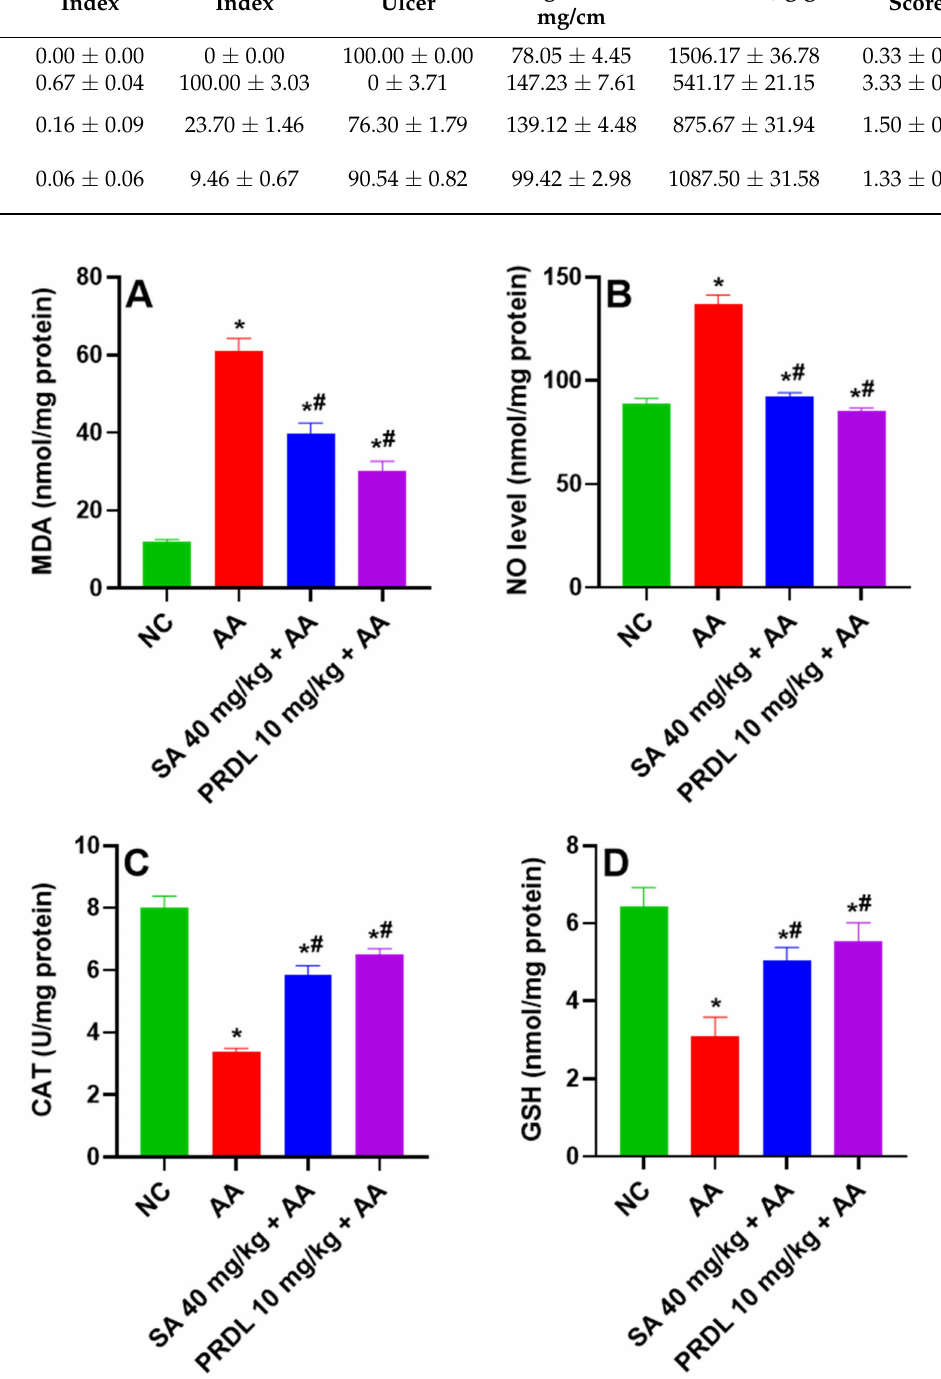
Figure 3. Levels of ( A ) MDA, ( B ) NO, ( C ) CAT and ( D ) GSH in in AA-induced ulcerative colitis rats. The results are presented as mean ± SEM ( n = 6) per group. * denotes significant differences compared to the control group ( p < 0.05); # denotes significant differences compared to the AA group ( p <